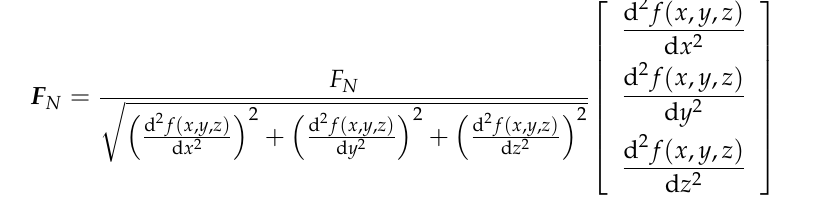
The particle P is always directly contacted with the mantle surface in the spatial sliding.